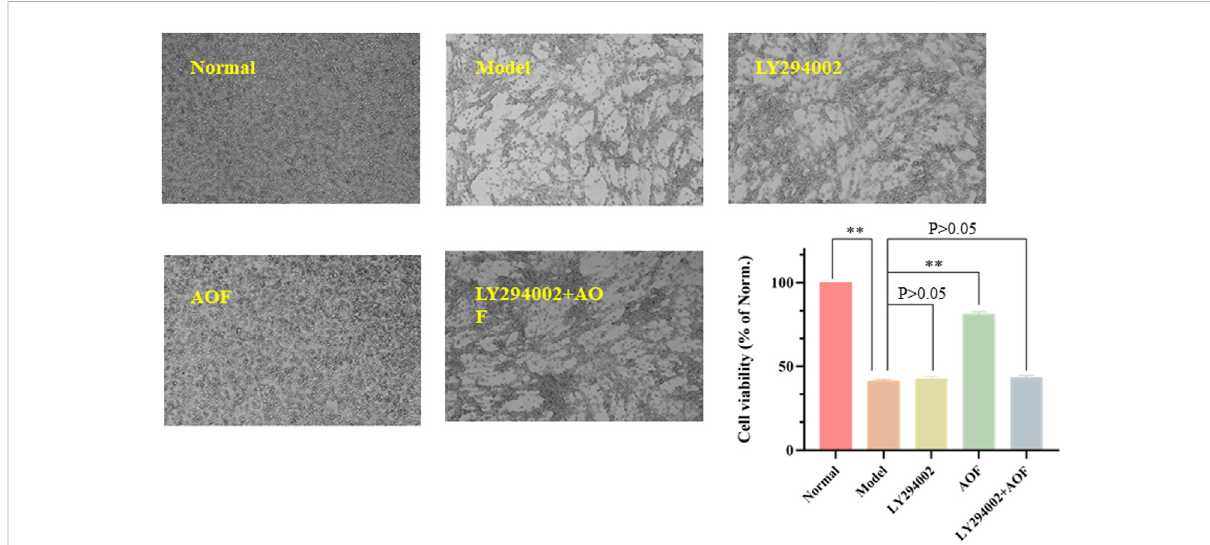
FIGURE 13 EffectsofPI3KinhibitorLY294002 ontheviability ofPC12cells.ThePC12cellswerepretreatedwithLY294002(20 μ M)ornotfor1 h;thencells were treated with AOF (80 μ g/ml) for 2 h, subsequently subjected to H 2 O 2 for 4 h. The values were represented as the mean ± SD ( n = 3). pp p < 0.01 vs. the model group.